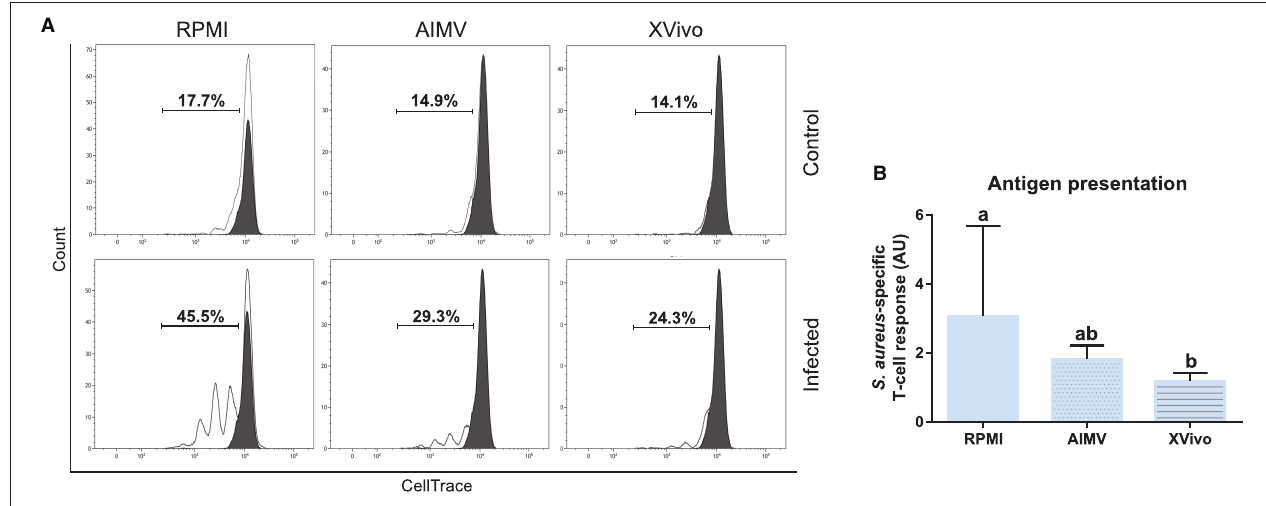
FIGURE 11 | Antigen presentation assay with moDCs produced in RPMI-FBS and serum-free media (AIM V and X-VIVO). (A) The percentage of T-lymphocytes proliferation was analyzed by flow cytometry after their co-culture with moDCs produced in three different media. Black and white peaks correspond to lymphocytes alone (non-proliferating control) and exposed to moDCs, respectively. The gates indicate the percentage of proliferating lymphocytes. Histograms show the results of one representative experiment. (B) The bar plot depicts the levels of S. aureus- specific T-cell response. Data from three independent samples (from different animals) were calculated as a ratio between the percentage of T-cell proliferation upon co-culture with infected and control moDCs. Different letters represent mean statistically significant difference ( p < 0.05). Error bars represent